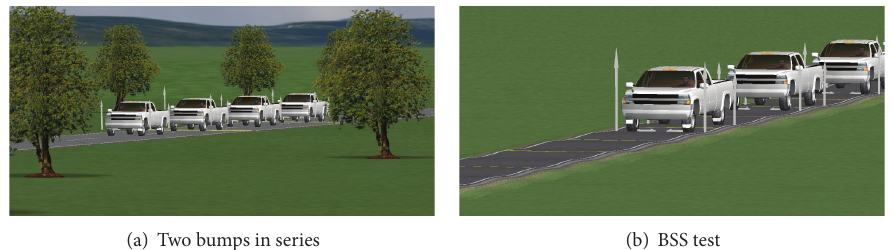
Figure 10: Simulation tests in CarSim used in the evaluation of the